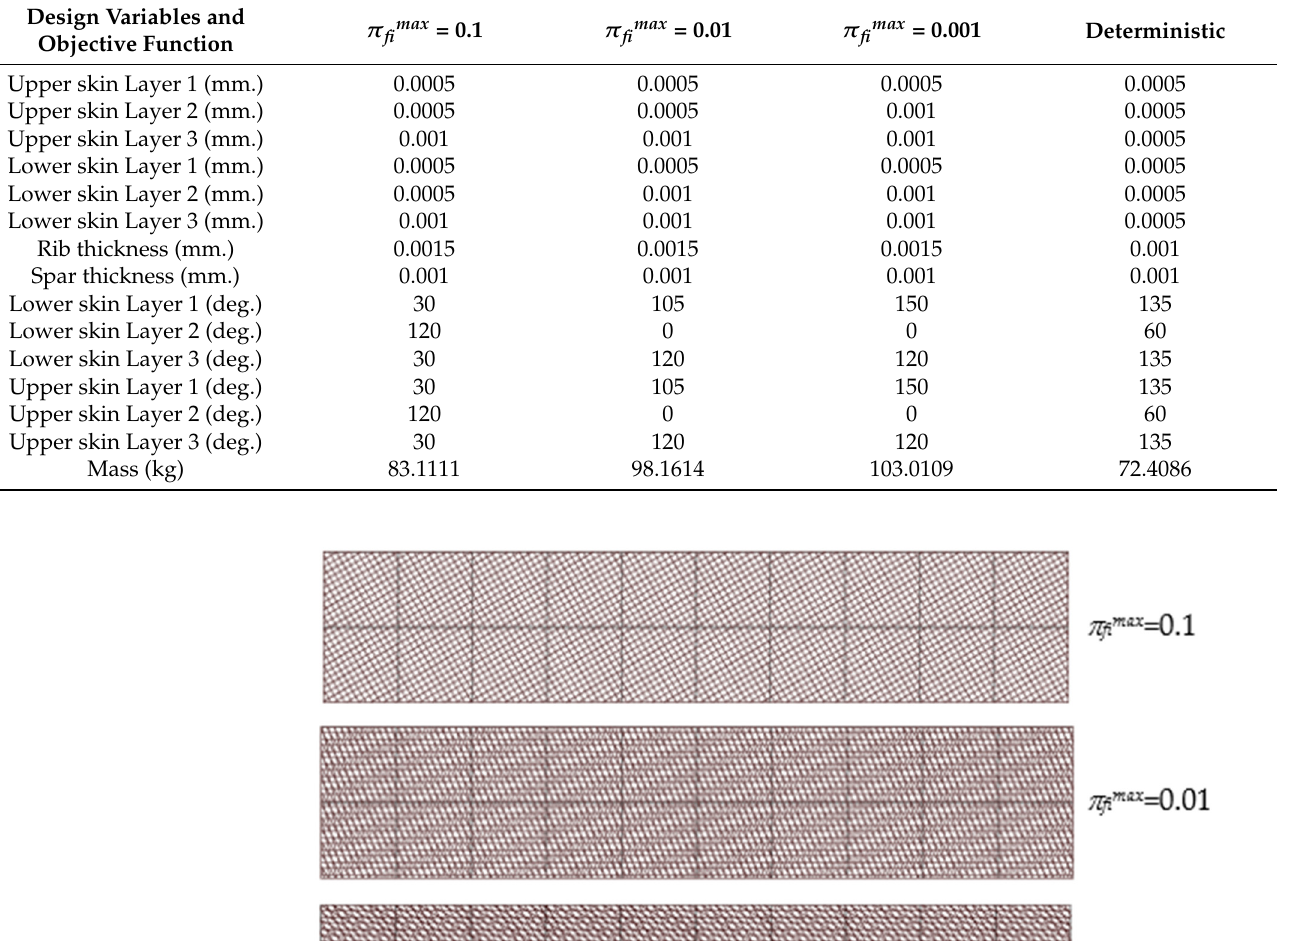
Table 3. Design variables of optimum solutions for the aircraft wing design by PSIBDO.